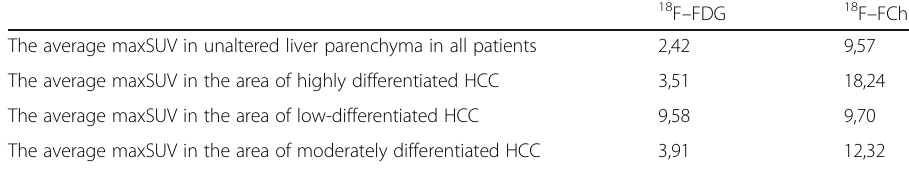
Table 2 Average values of accumulation of 18F – FDG and 18F – FCh in tumor sites and in the normal hepatic